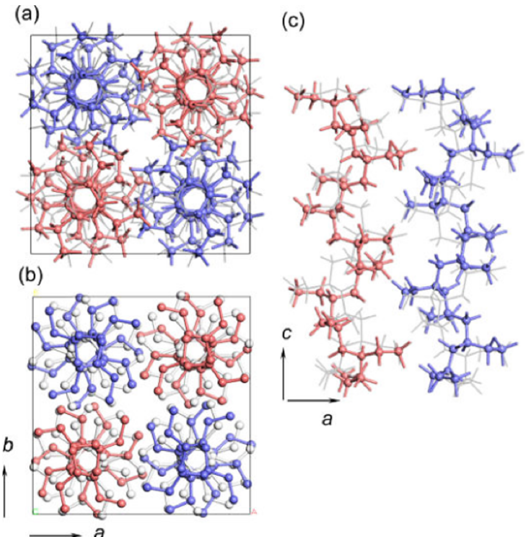
Figure 2. Crystal structure of iPBu form II looking along the c - ( a , b ) and b -axes ( c ), respectively. Reproduced with permission from Ref. [23], copyright 2016 American Chemical Society.